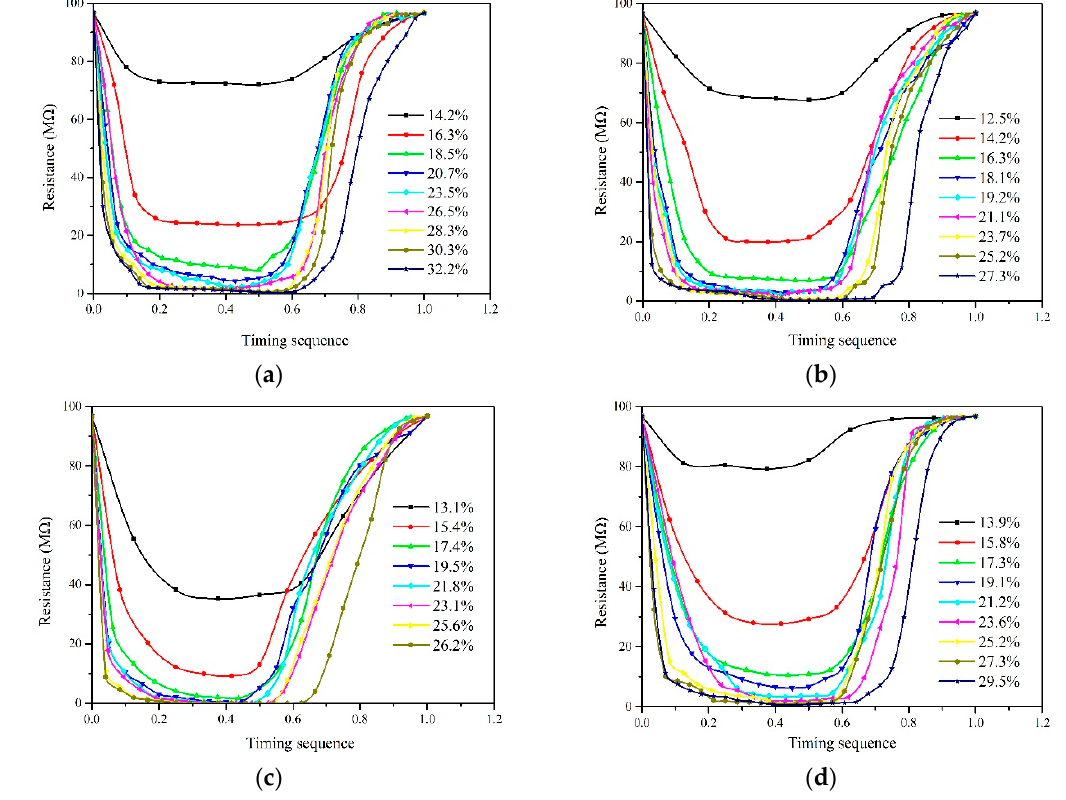
Figure 9. Normalized waveforms of electrical properties of four species in extruding process. ( a ) Xiangzaoxian 45; ( b ) Lumai 21; ( c ) Longpimai 2; ( d ) Nanjing 9108.